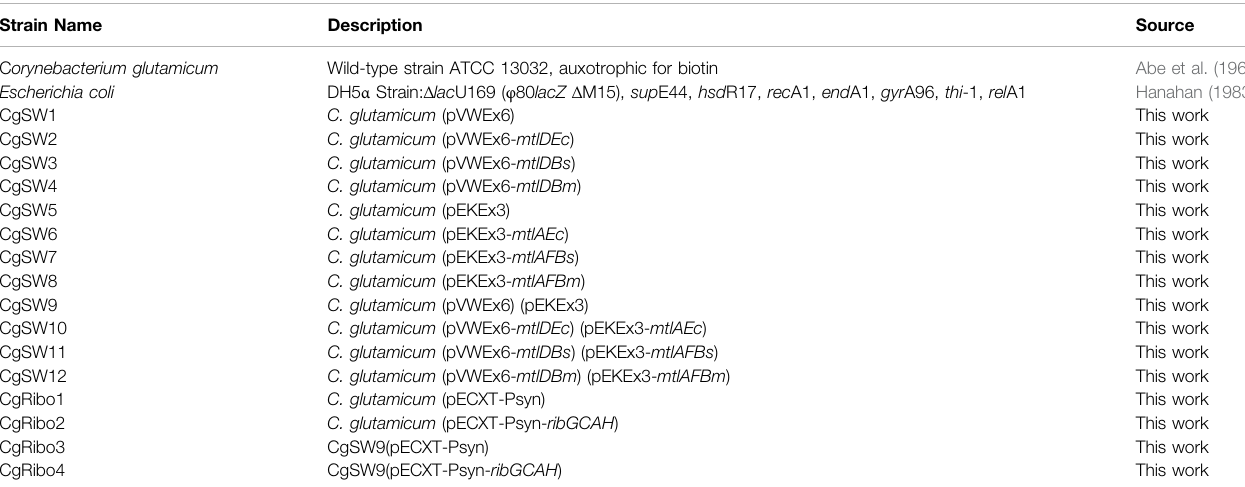
TABLE 2 | List of strains used in this